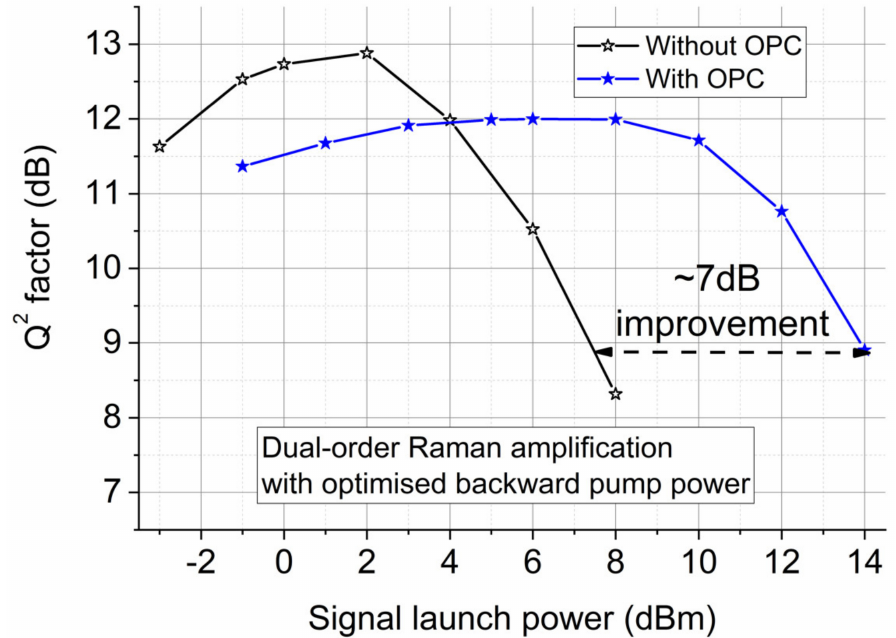
Figure 6. Experimentally measured Q 2 factors versus signal launch power in inline transmission systems without/with OPC using the optimized dual-order DRA scheme over 2 × 50 km